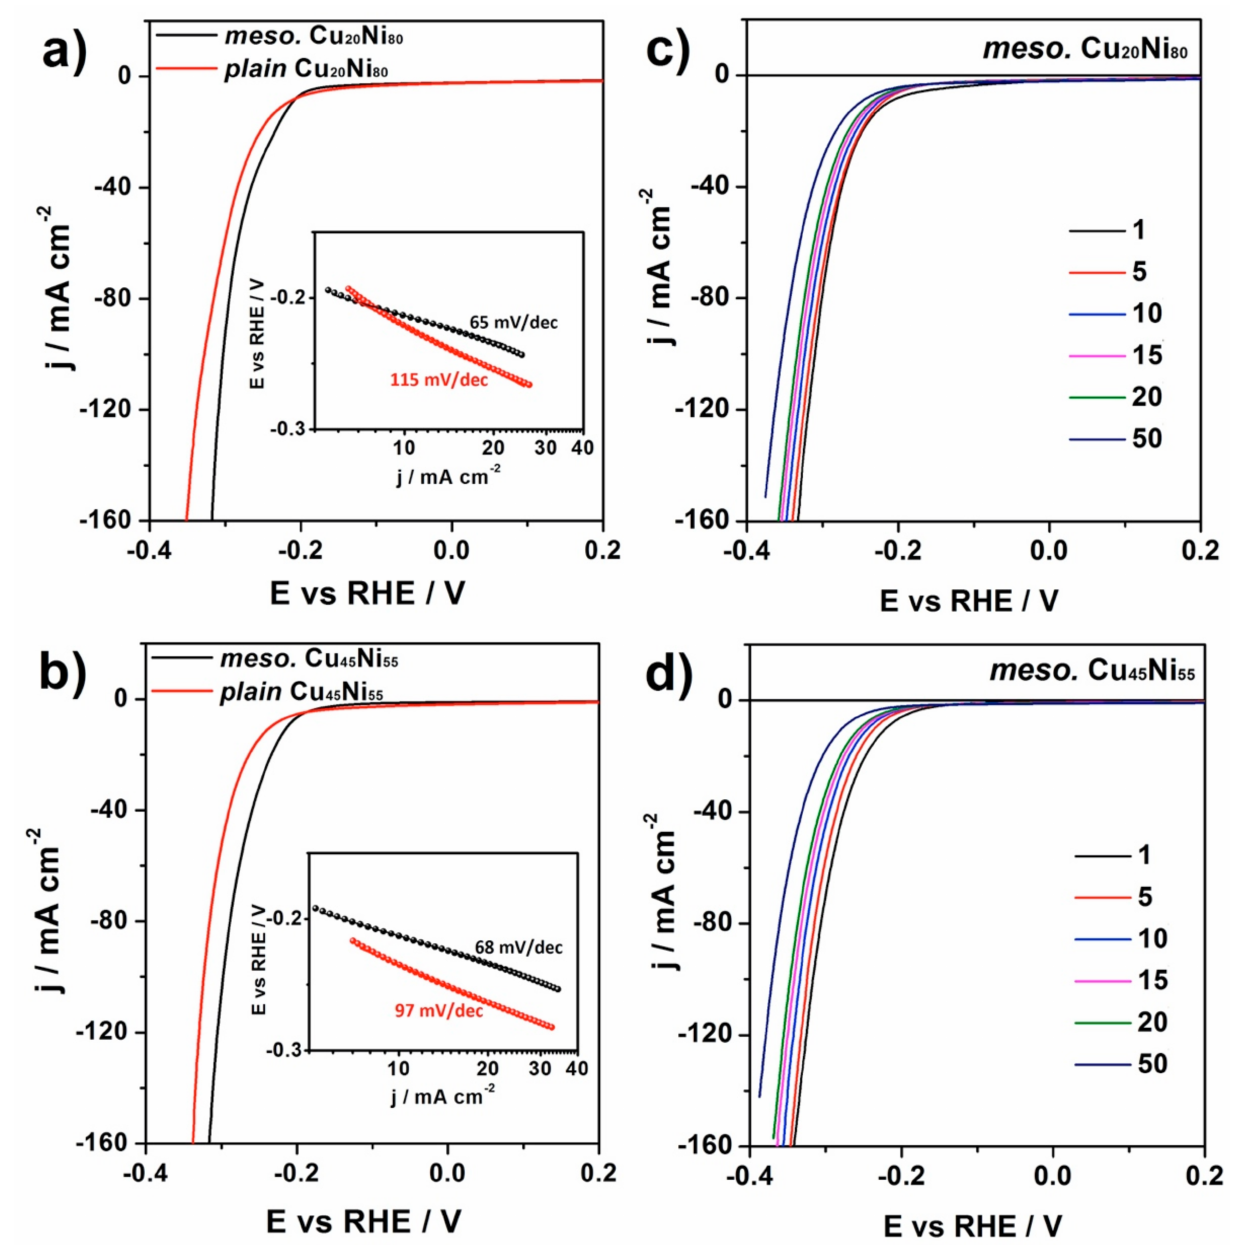
Figure 9. Cathodic-going linear sweep voltammetry curves for comparison between plain and surface-mesostructured ( a ) Cu 20 Ni 80 and ( b ) Cu 45 Ni 55, and the variation in HER current density as a function of the number of scans for ( c ) Cu 20 Ni 80 and ( d ) Cu 45 Ni 55 . All curves were recorded in recorded in 1 M KOH at a scan rate of 50 mV · s − 1 and 298 K. The insets in ( a ) and ( b ) show the Tafel